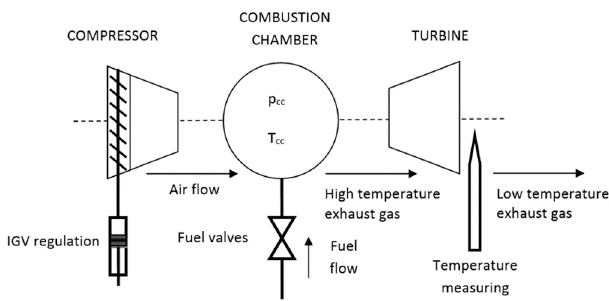
Figure 1. Typical heavy-duty gas turbine (GT) schematic layout.